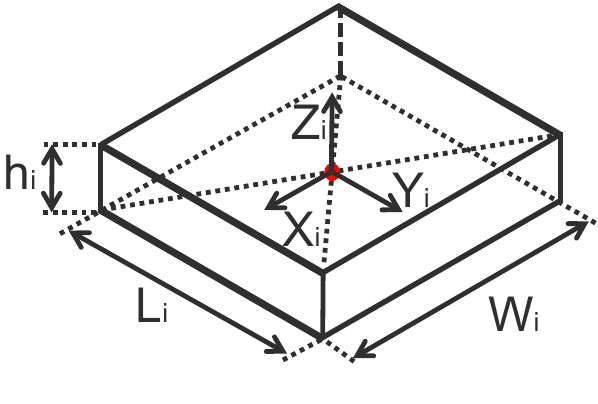
Figure 10: Dimensions of a rectangular